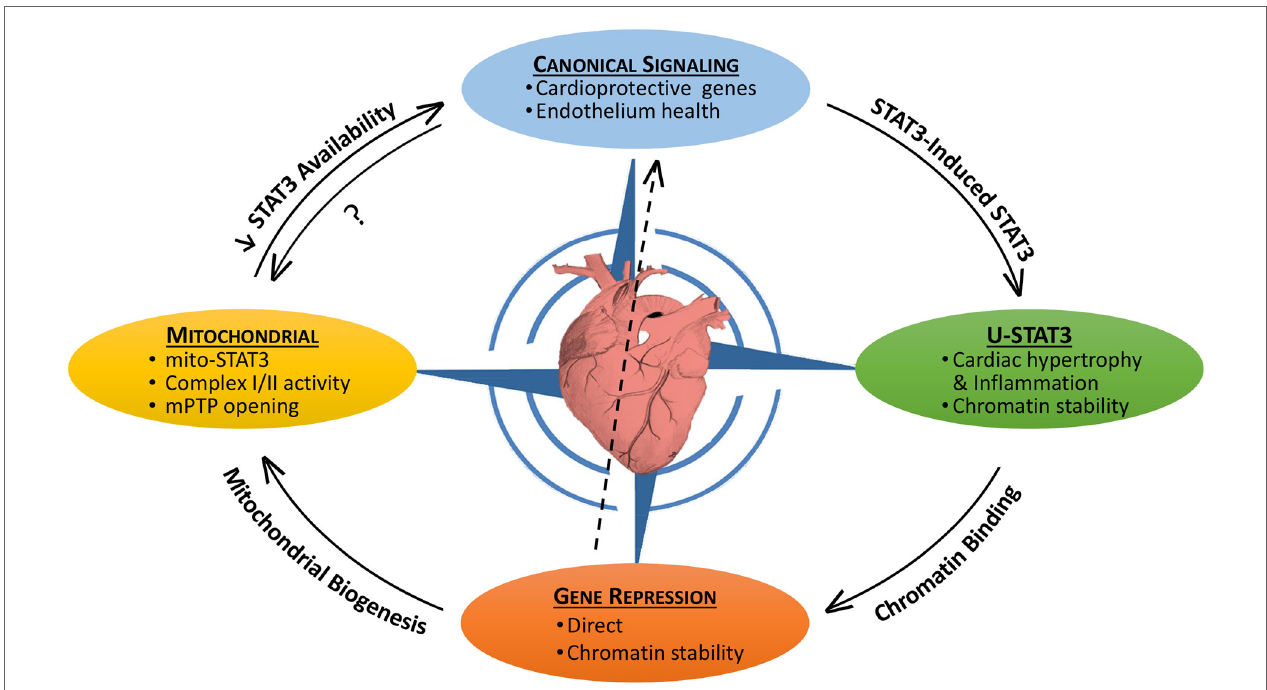
FiGURe 1 | The pleotropic actions of STAT3 in the heart and their interplay . STAT3 has both canonical and non-canonical actions that impact on the viability of the myocardium. Canonical STAT3-induced gene expression is associated with the upregulation of protective anti-oxidant and anti-apoptotic proteins, as well as maintaining the heath of the endothelium (e.g., by upregulating VEGF and SOD2). STAT3 induces its own expression leading potentially to the accumulation of unphosphorylated STAT3 (U-STAT3) in the nucleus, which has been associated with hypertrophy and inflammation. U-STAT3 may contribute to chromatin stability and gene suppression. STAT3 also directly suppresses/represses genes possibly by association with DNMT1 or HDACs. Loss of STAT3-mediated suppression of miR-199a-5p has been linked to endothelial dysfunction (center arrow). Gene repression may be important for mitochondrial biogenesis. STAT3 has direct mitochondrial actions that are poorly understood, but involve maintaining complex I/II activity and preventing mPTP opening. By sequestering STAT3 (perhaps involving redox modifications), mitochondria may reduce the nuclear transcriptional actions of STAT3. Canonical STAT3 signaling is likely important for mitochondrial health as